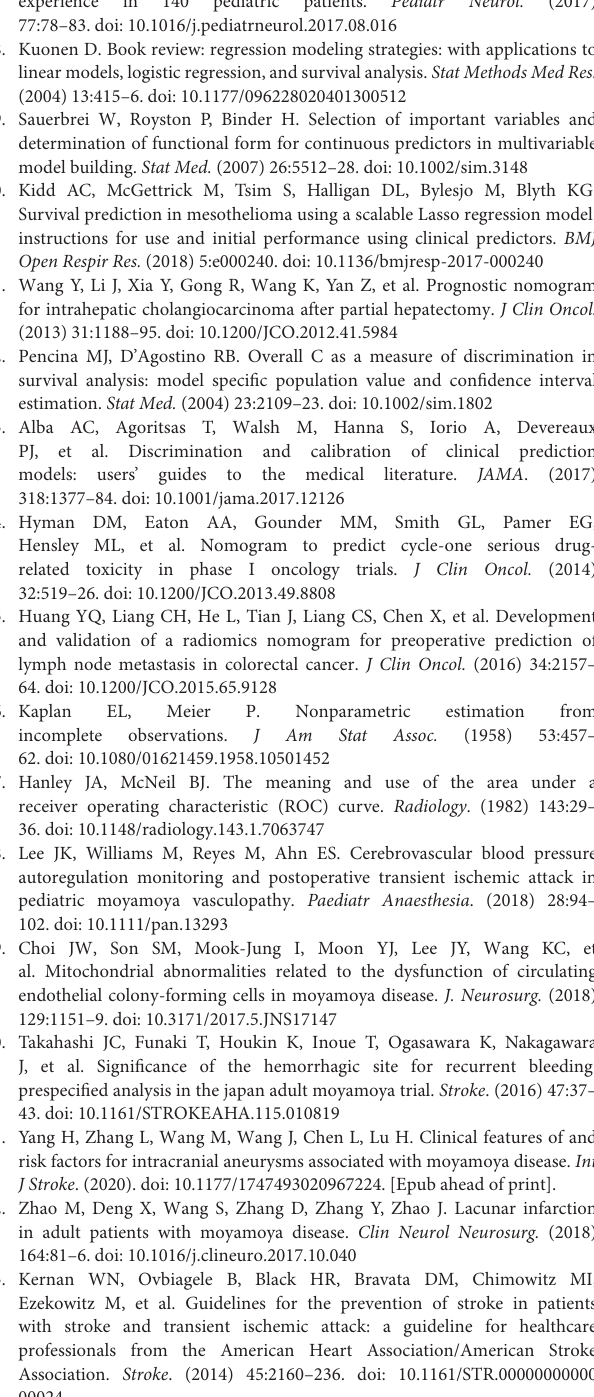
Supplementary Table 2 | The training set of 300 adult patients with moyamoya disease. Supplementary Table 3 | The test set of 150 adult patients with moyamoya disease.